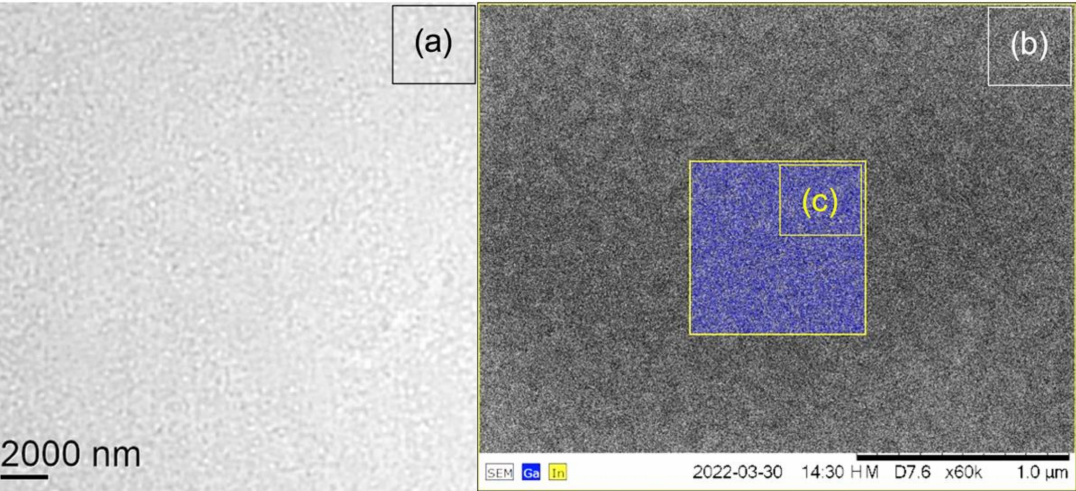
Figure 8. Optical light micrograph of (20 µ m) 2 surface area in reflection ( a ) and BSE image ( b ) with X-ray map insert of (0.9 µ m) 2 area ( c ) with Ga K counts in blue (min = 41, max = 209) and In L counts in yellow (min = 0, max = 5). All bright dots in ( c ) are yellow and, despite the noise, align well with the white dot pattern in ( b